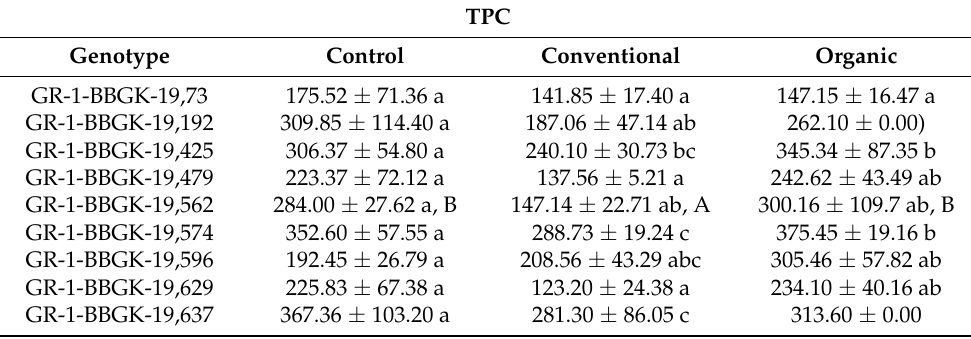
Table 5. Effect of fertilization regimes (conventional, organic, and control with no